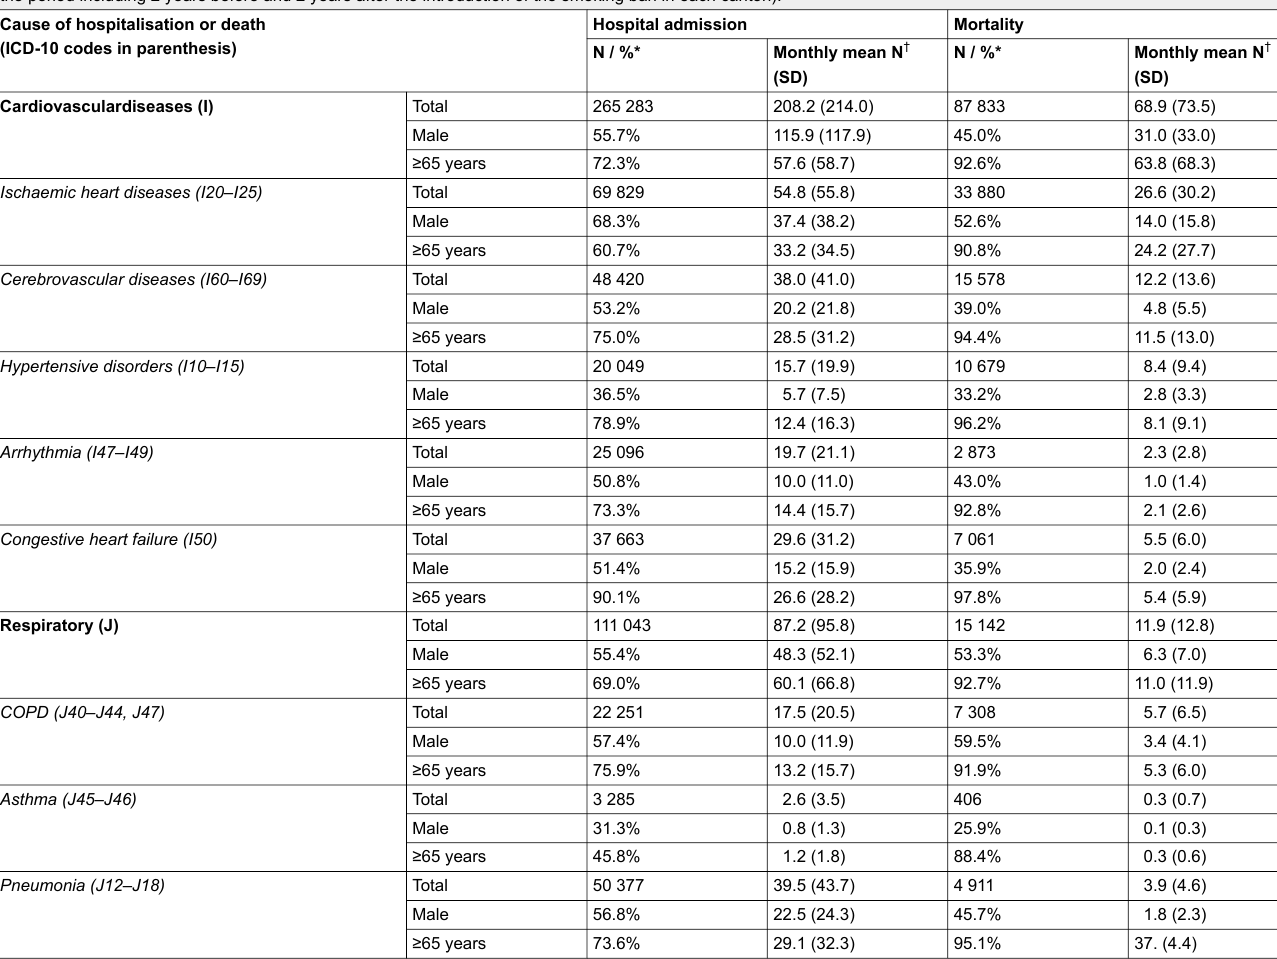
Table S2: Description of the gender- and age-specific series of mortality and hospital admissions in adults (≥35 years old) for the main groups of causes (data restricted to the period including 2 years before and 2 years after the introduction of the smoking ban in each